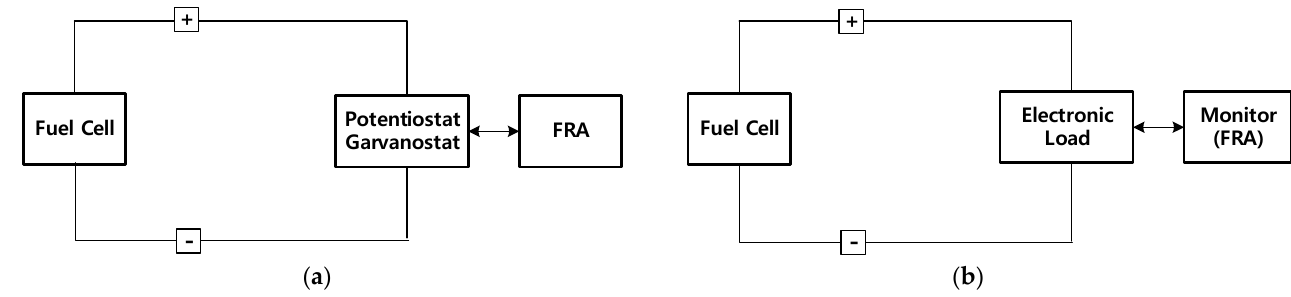
Figure 1. Configuration of laboratory environment EIS. ( a ) Normal EIS configuration. ( b ) EIS configuration for enhanced capacity.